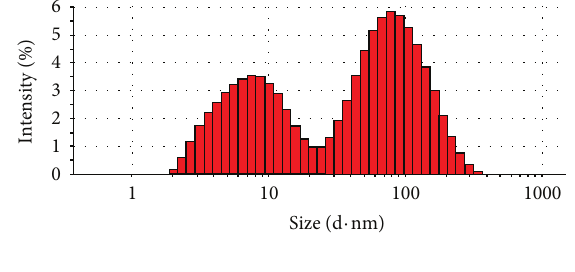
F 2: Laser scattering image of the Te particles. 1.2mmol